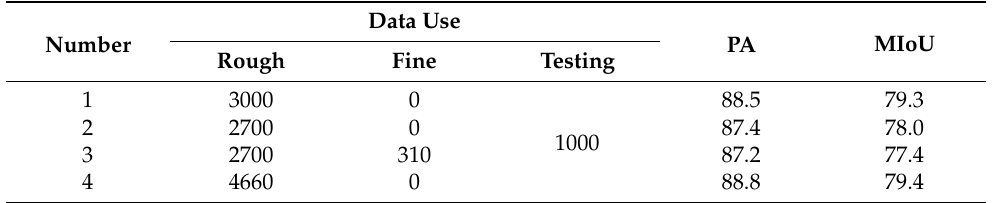
Table 3. Results of a different data use strategy on dataset 2.